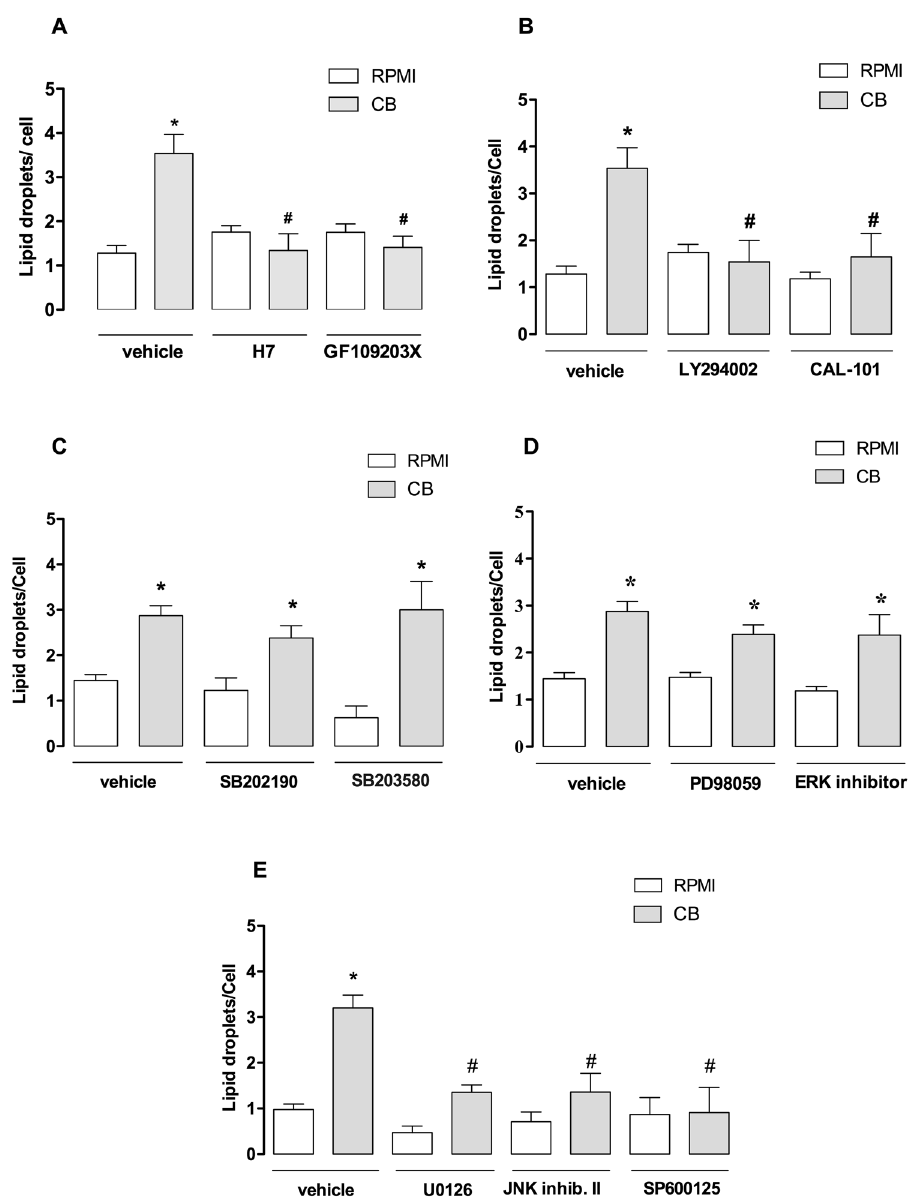
Figure 3. Signaling pathways involved in CB-induced LD formation in macrophages. Macrophages were incubated with one of the following inhibitors before stimulation with CB (0.4 µ M) for 3 h: ( A ) PKC inhibitors H7 (6 µ M) or GF109203X (1 μ M) for 1 h, ( B ) PI3K inhibitors LY294002 (1 µ M) or CAL101 (1 µ M) for 1 h; ( C ) p38 MAPK SB inhibitors SB201290 (5 µ M) or SB203580 (16 µ M); ( D ) ERK1/2 inhibitors PD98059 (25 µ M) or ERK inhibitor (5 µ M) for 1 h; ( E ) MEK1/2 inhibitor, U0126 (25 µ M) or JNK inhibitors JNK inhibitor II (2 μ M) or SP600125 (10 µ M) for 1 h. LDs were counted using light microscopy after osmium staining. Each bar represents the mean ± SEM of the number of LDs/cell in 50 cells. Values represent means ± SEM for three to five animals. * p < 0.05 compared with RPMI/vehicle-stimulated cells; # p < 0.05 compared with vehicle treated/CB-stimulated